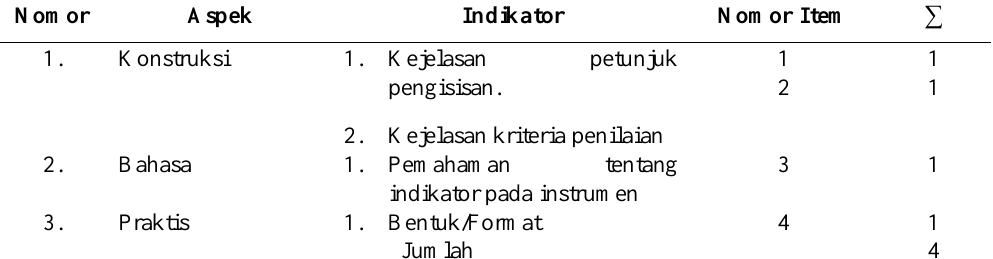
Table 2 . Kisi-kisi Angket Respon Guru dan Peserta Didik Nomor Aspek Indikator Nomor Item